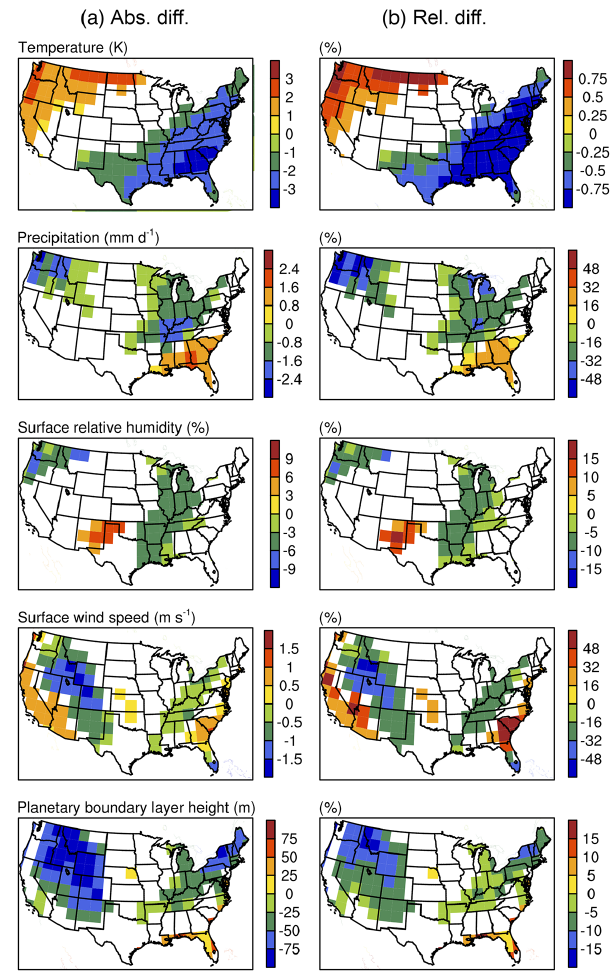
Figure 7. (a) The absolute and (b) relative differences in mete- orological parameters between PNA + and PNA − months. data sets are from the assimilated GEOS-4 meteorological fields. The white spaces in indicate the areas that did not pass the two-tail stu- dent t test with 90% significance level. The seasonal cycles of me- teorological variables were removed, similar to the treatment for observations in Fig. 3. See Fig. 2c for the definitions of PNA + and PNA −